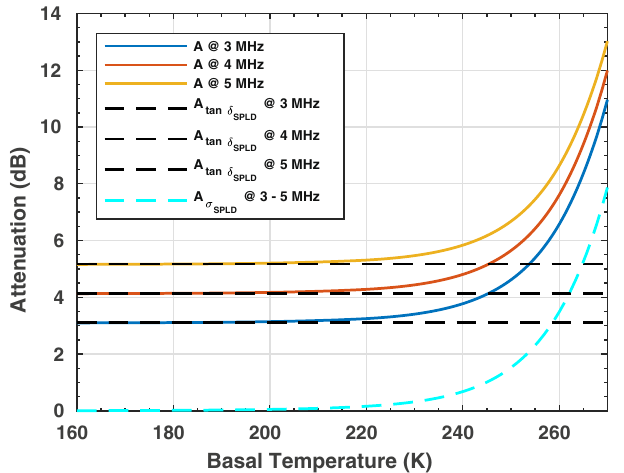
Fig.3|Attenuationinanice/dustmixtureatMARSISfrequencies. Solidlinesare computed using Maxwell-Garnett mixing formula (see Methods) assuming a 12% dustcontentandtan δ d =1 : 7×10 (cid:1) 2 ,admixedwithpurewaterice.Blackdashedlines are computed using the same mixing formula and negligible ice conductivity. The cyandashedlineiscomputedassumingnegligibledustlosstangent.Allcurvesrefer to 17 : 5 μ s two-way travel